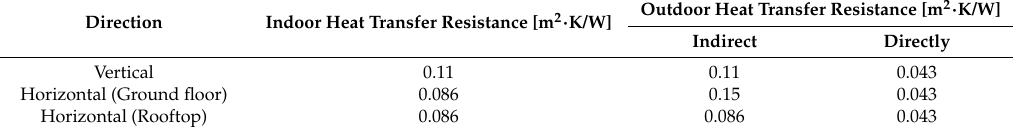
Table 1. Values of indoor and outdoor heat transfer resistance according to the Korean Energy Saving Design Standard.